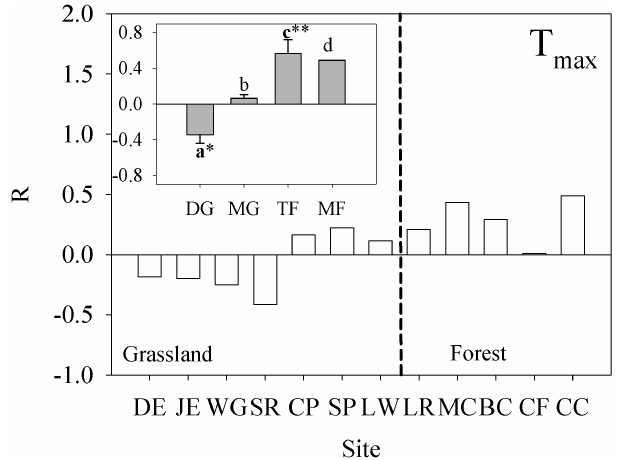
Figure 5. Partial correlations between iEVI and T max after control- ling the effects of T min and precipitation across sites. (1) Statisti- cally significant at the 95% ( P < 0.05) level; (2) statistically sig- nificant at the 99.9% ( P < 0.001)